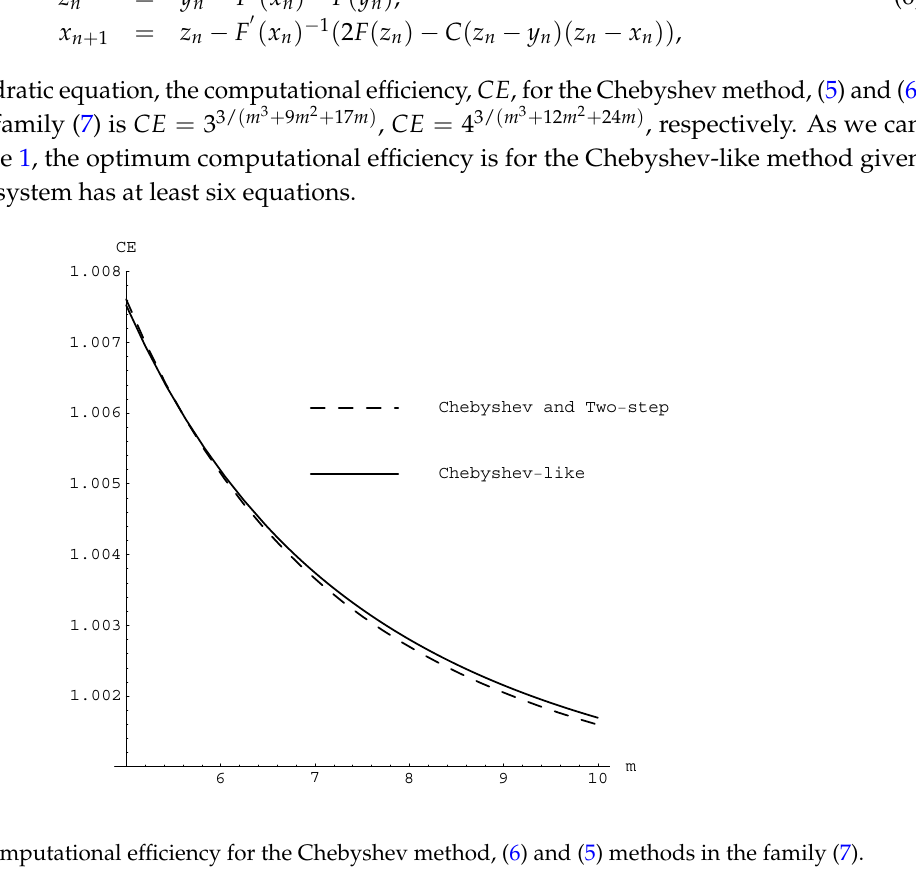
Figure 1. Computational efficiency for the Chebyshev method, (6) and (5) methods in the family